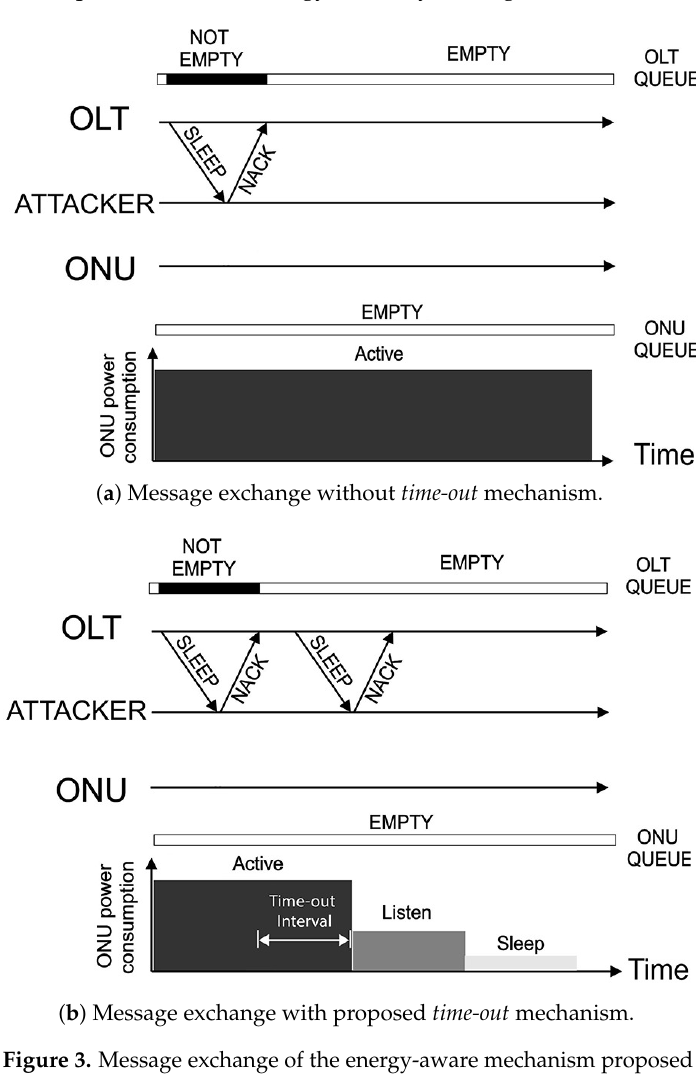
Figure 3. Message exchange of the energy-aware mechanism proposed in [21], as well as when using the time-out